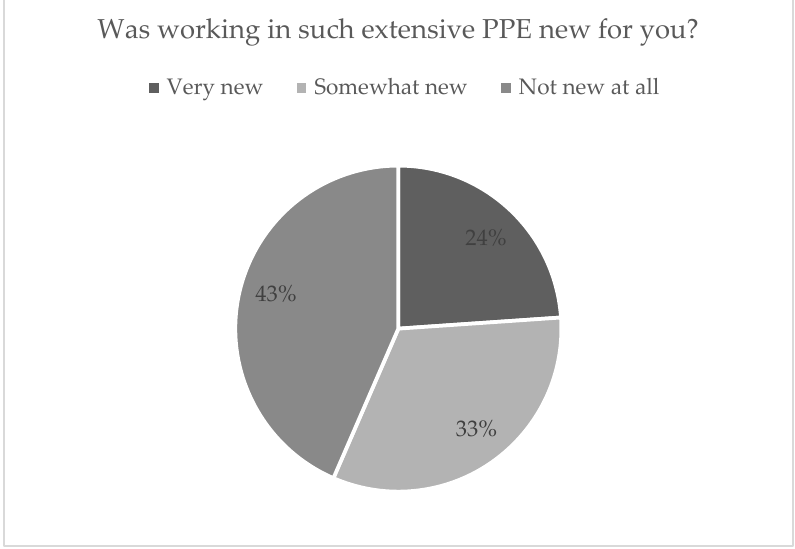
Figure 2. Of the 46 participants who answered this question, 57% indicated that working in SP Level 1 and Level 2 was new, with 24% labeling it as very new.